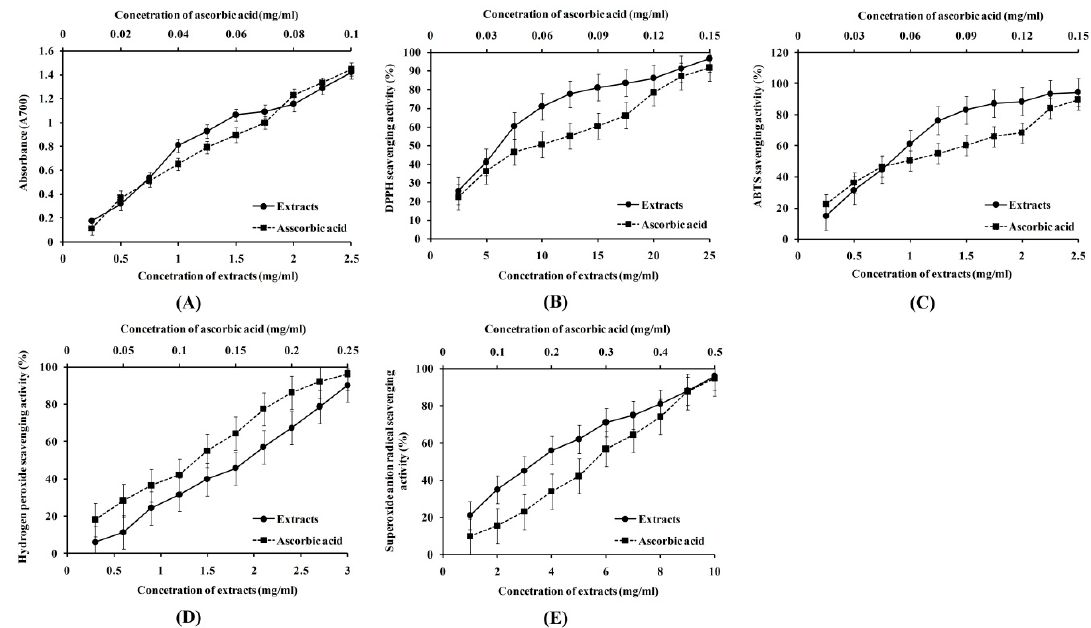
Figure 3. Antioxidant activities of ascorbic acid and the Saussurea involucrate flavonoids (SIFs) extract. ( A – E ) were the ferric ion reducing activity, DPPH radical scavenging rate, ABTS + radical scavenging rate, hydroxyl radical scavenging rate and superoxide anion scavenging rate, respectively.